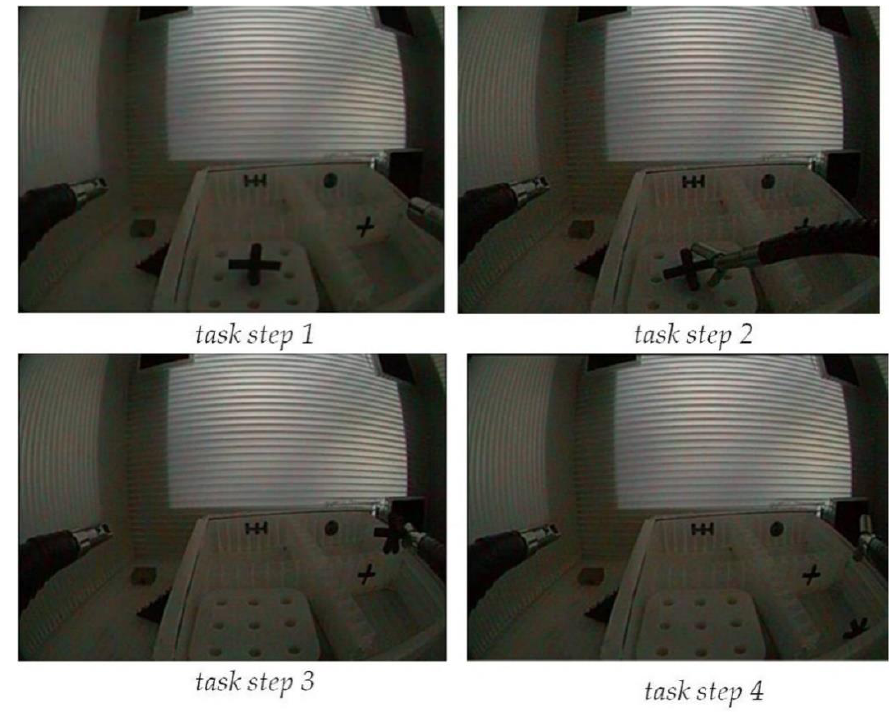
Figure 4. Snapshot views of the four successive steps of the pick-and-drop task when executed with the right hand by manipulating the corresponding instrument of the robotic system.